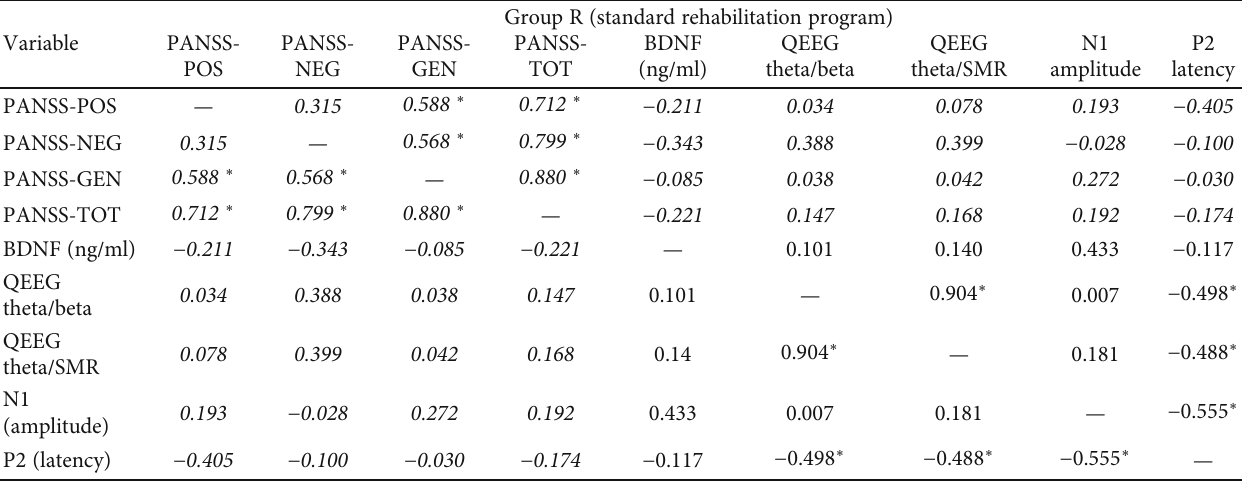
Table 3: Correlations between the magnitude of changes from pretherapy to posttherapy measurements in the group of patients following a standard rehabilitation program (group R).